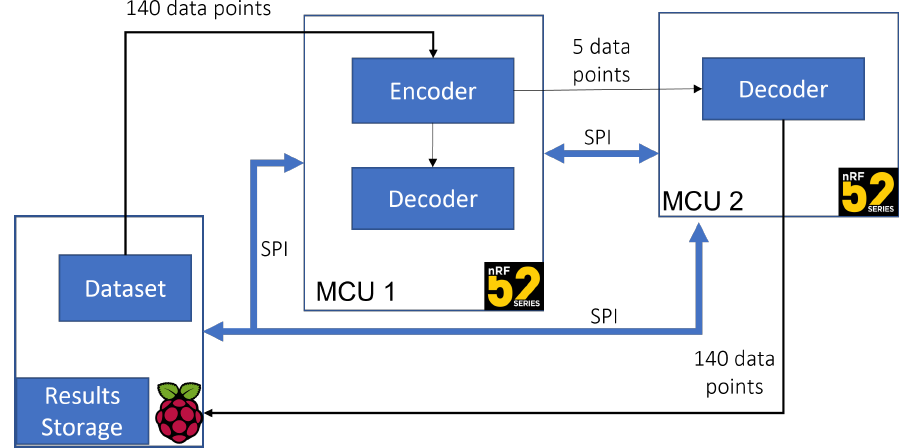
Figure 6. Test set-up.